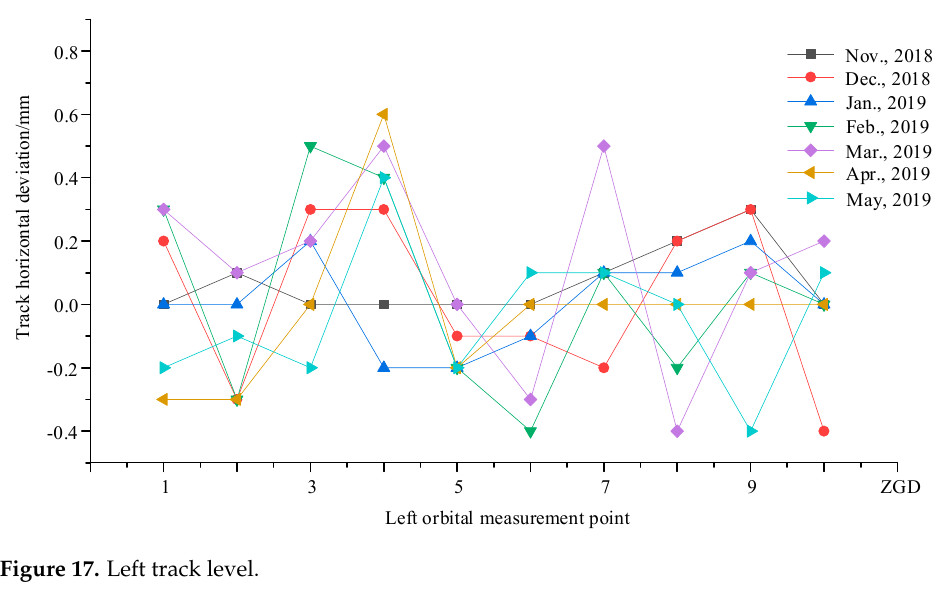
Figure 17. Left track